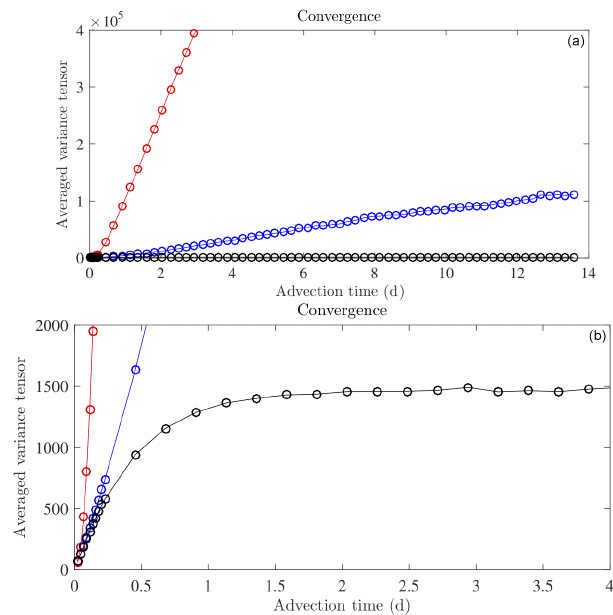
Figure 6. Estimation of the spatial average of the trace of (cid:80) M ( a ( x q )) = the variance tensor divided by d = 2, 1 q = 1 tr Md (cid:80) 1 (cid:107) ξ (cid:107) 2 , as a function of the Lagrangian advection i ( x q ) q,i Md time (cid:49)T , for method 1 (described in Sect. 2.2) (blue plot) and for method 2 (the flow increments defined by the integration of m = the small-scale velocity along the high-resolution flow: (cid:103) (cid:49) X ij (cid:82) (k + 1 )(cid:49)T ( u − u )(t, X ij (m(cid:49)T,t)) d t ) (black plot). The red plot re- k(cid:49)T lies on another method not described here. The bottom plot is an enhancement of the top plot. For low (cid:49)T values, the Lagrangian velocities remain highly correlated during the interval [ 0 ,(cid:49)T ] , i.e. during the Lagrangian advection. It is the ballistic regime where m (cid:107) ∝ (cid:49)T . In that the flow increments scale linearly in time: (cid:107) (cid:103) (cid:49) X ij regime, methods 1 and 2 are very similar, since the high-resolution, X ij (m(cid:49)T,t) , and low-resolution, X ij (m(cid:49)T,t) , flows remain close to each other. Above (cid:49)T = 1d, the final and initial small-scale Lagrangian velocities, ( u − u ) , are decorrelated. It is the diffusive regime where the flow increments scale as the square root of time: √ (cid:107) (cid:103) (cid:49) X m (cid:107) ∝ (cid:49)T . This is the relevant regime for the estimation of ij the EOF, since we meet the fundamental assumption of our model: a Brownian behaviour for the small-scale flow. For method 1, the dif- fusive regime is not visible, at least in this advection time window, and the EOF estimation is theoretically not possible. In contrast, method 2 provides a converged estimator of the variance tensor for an advection time (cid:49)T >